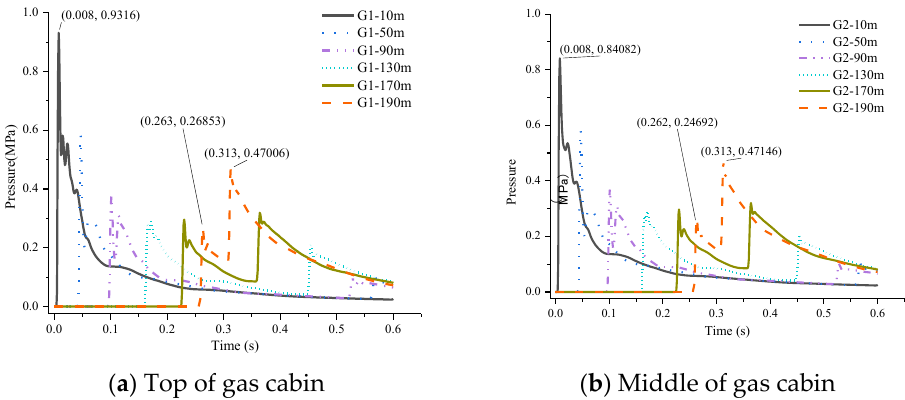
Figure 11. Overpressure-time curves of each monitoring points in the top and middle of the gas cabin